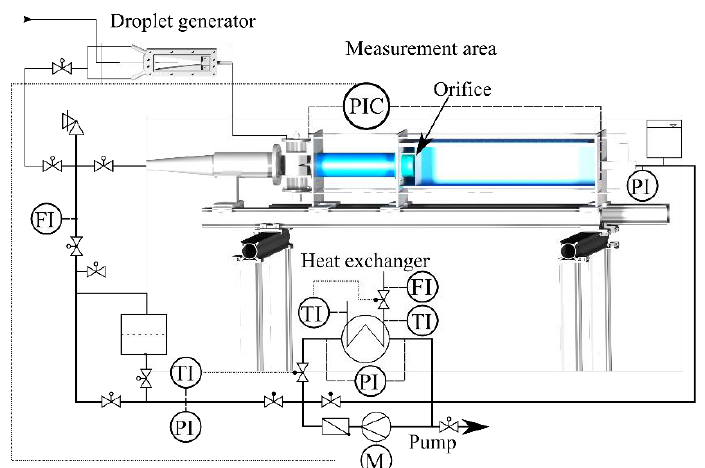
Figure 3. Experimental setup of the 50-fold scaled system ( Ψ = 50 ) with the optically accessible inlet, outlet channel and orifice. The continuous phase is circulated by a centrifugal pump. The droplet generator was not used and disconnected during velocity measurements. The temperature (TI), the volume flow (FI) and the pressure (PI) are indicated at several places in the test rig. The motor of the pump (M) is controlled according to the pressure signal of the orifice pressure drop sensor (PIC).